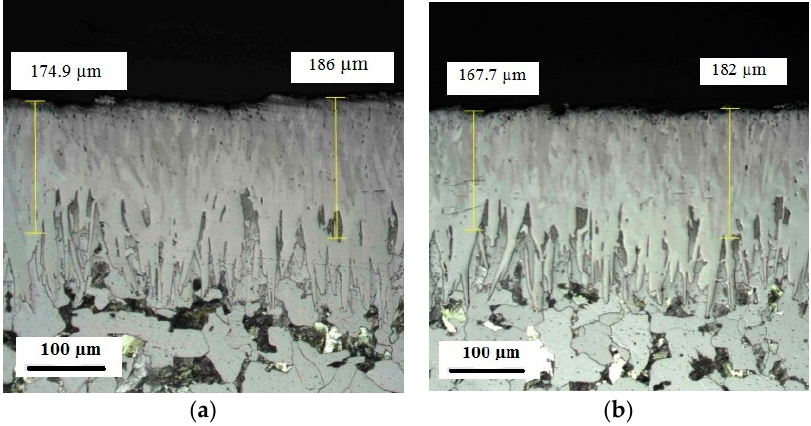
Figure A4. Microscopic images of the cross-section of CS-B ( a ) before and ( b ) after the low-temperature corrosive attack after 168 h.